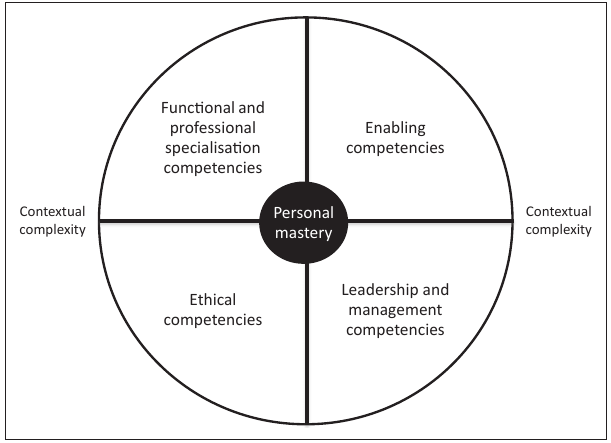
FIGURE 6: Phase 2: The competency clusters of the qualitatively expanded central banker competency model as constructed by the researchers.